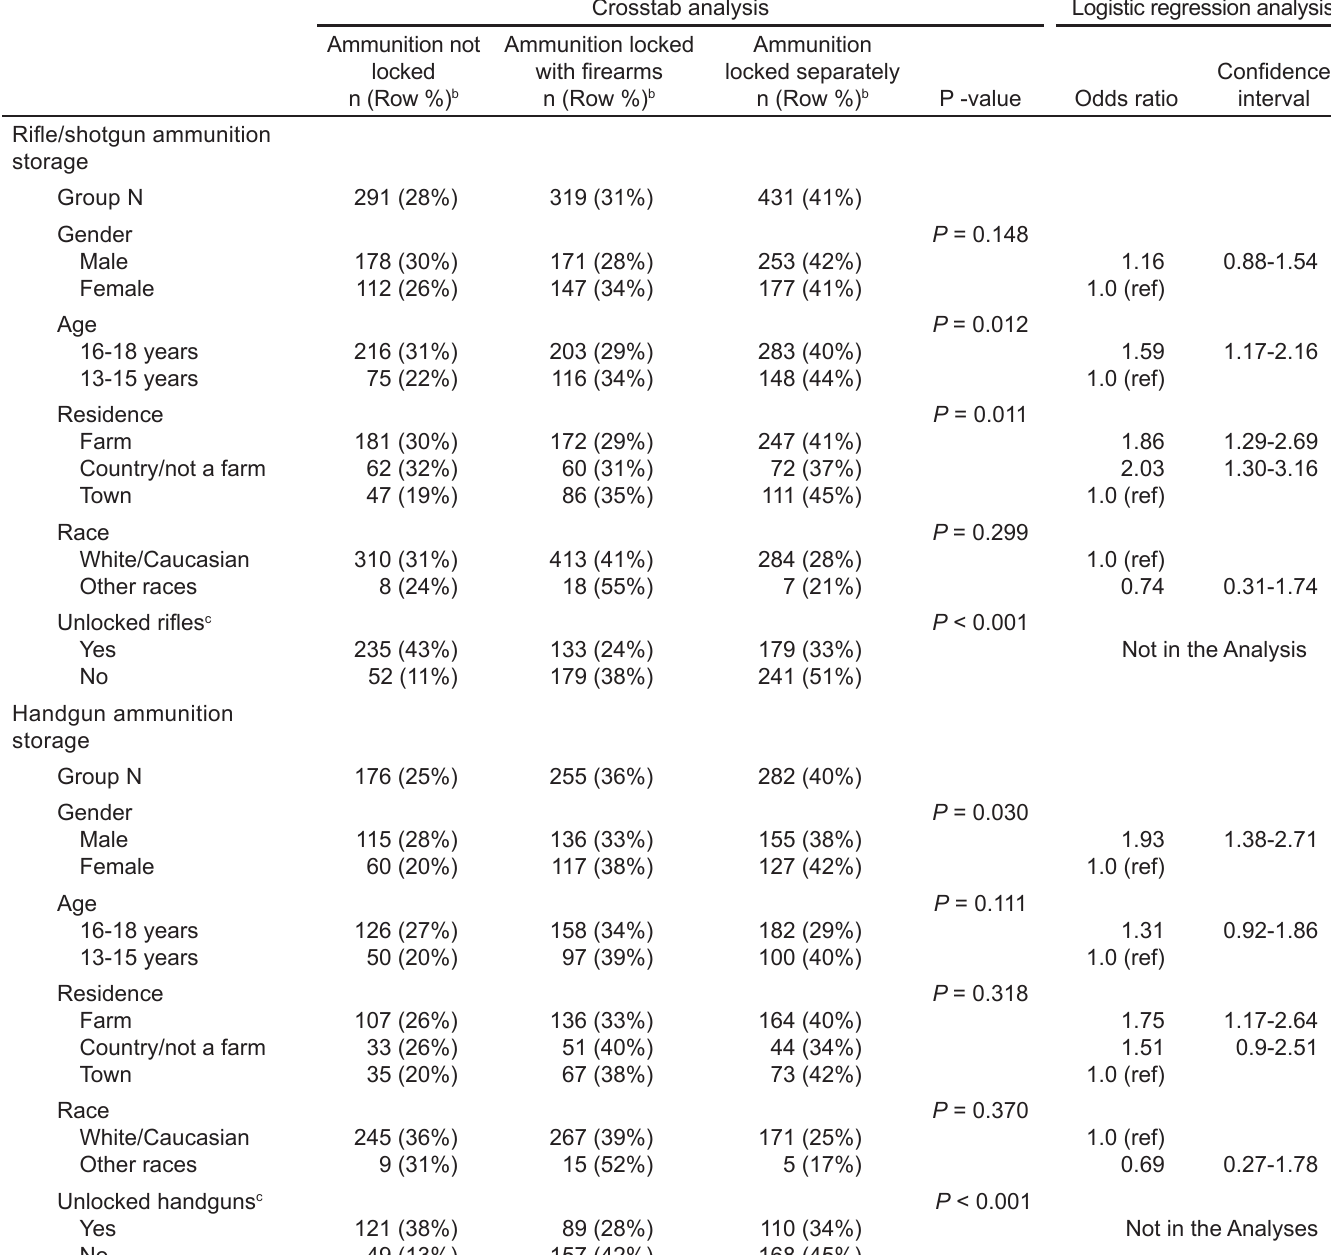
Table 7. Bivariate and multivariable logistic regression analyses regarding the storage of rifle/shotgun and handgun ammunition in the homes of adolescent survey respondents.